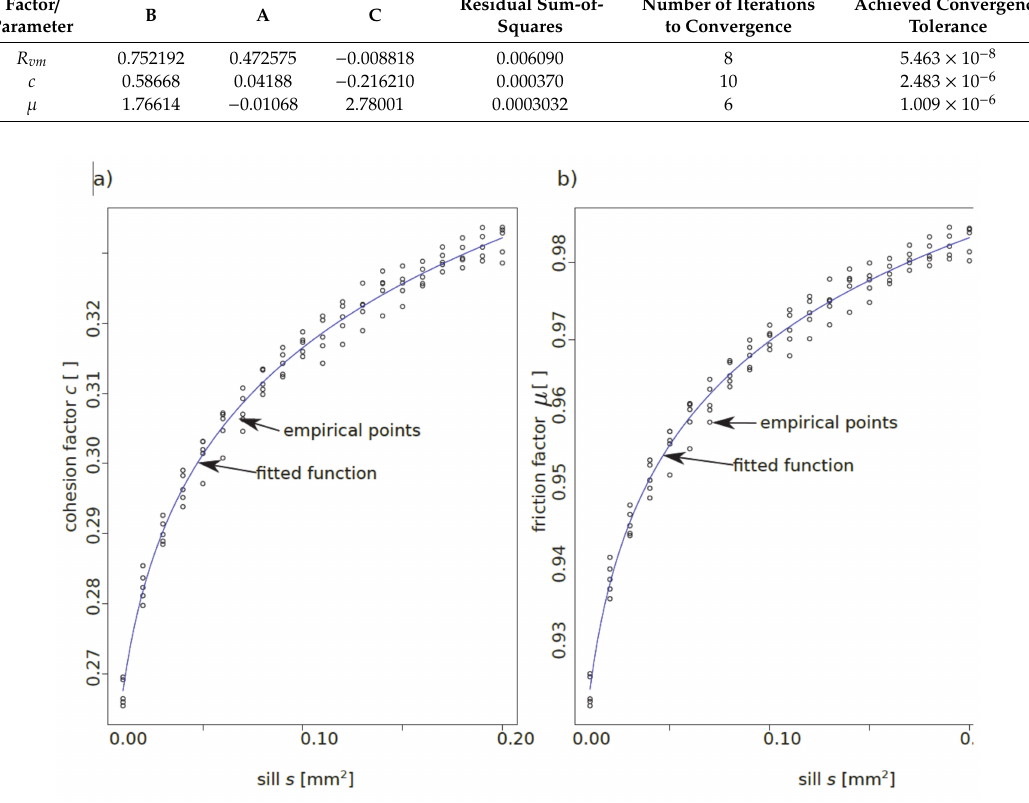
Figure 18. Results of fitting cohesion— c ( a ) and friction— µ ( b ) factors to the sill— s